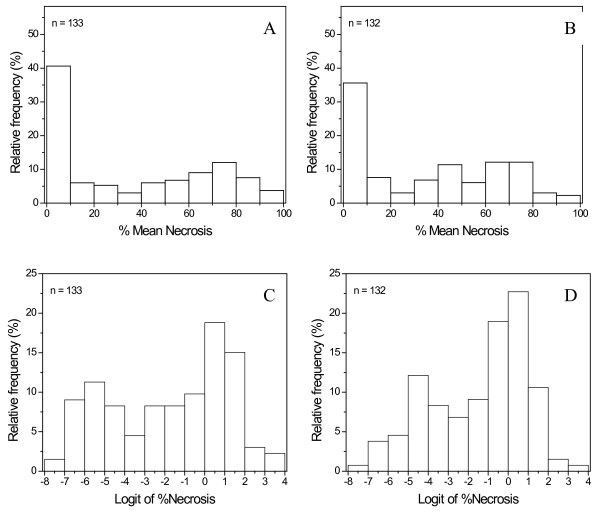
Distribution of fire blight severity in ‘Robusta 5’ populations from New Zealand and Germany. Histograms of fire blight mean % cumulative necrosis of current season’s shoot length over two seasons, presented as a percentage (top, A and B) and on the logit transformed scale (bottom, C and D), for the progeny of A/C: ‘Malling 9’ x ‘Robusta 5’ NZ and B/D: ‘Idared’ x ‘Robusta 5’ DE.